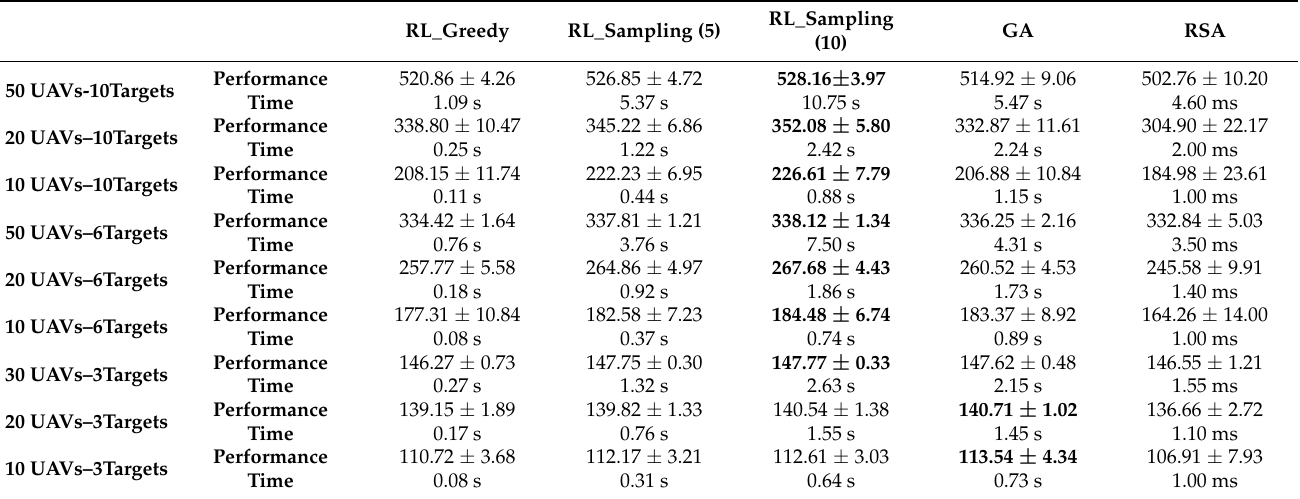
Table 5. Performance and running time of the